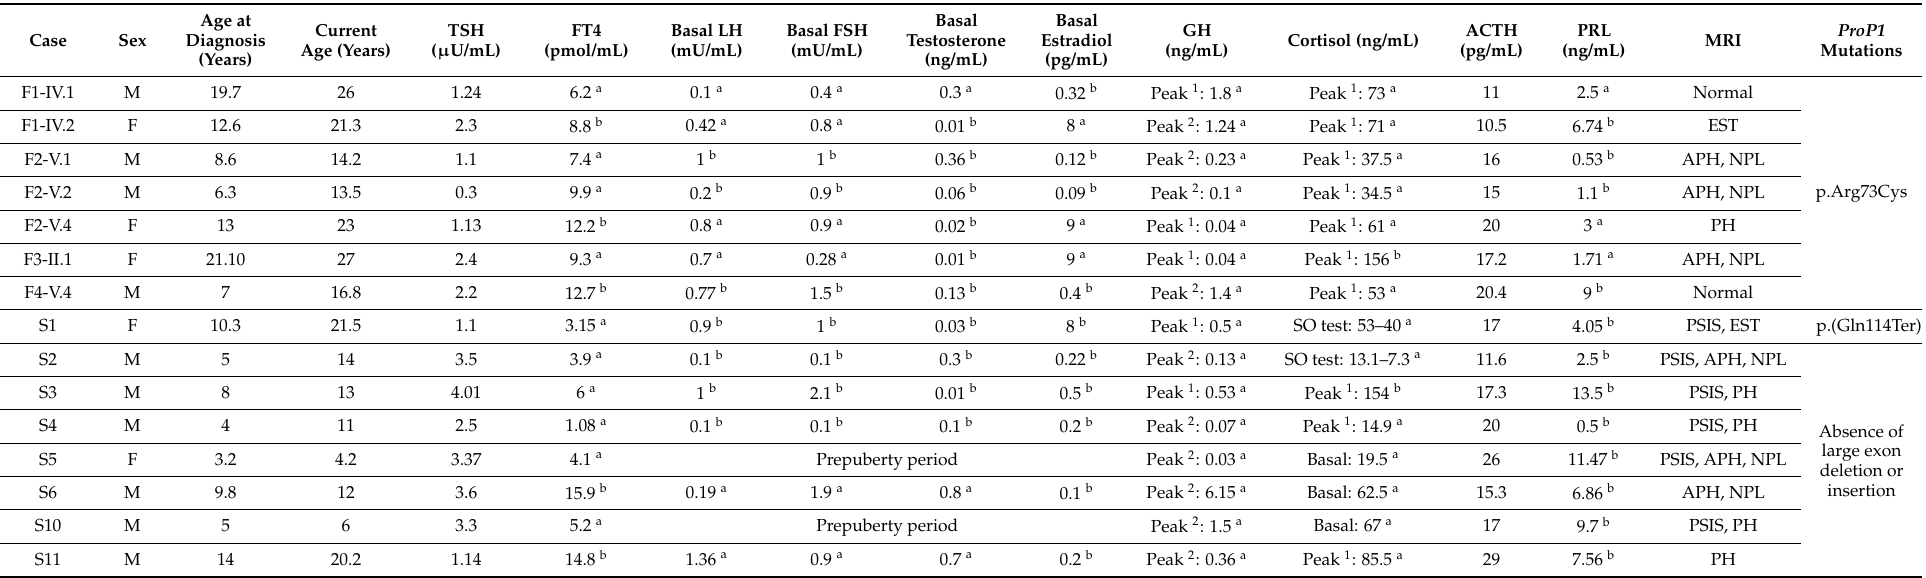
Table 1. Clinical features, hormonal follow-up and genotype of studied